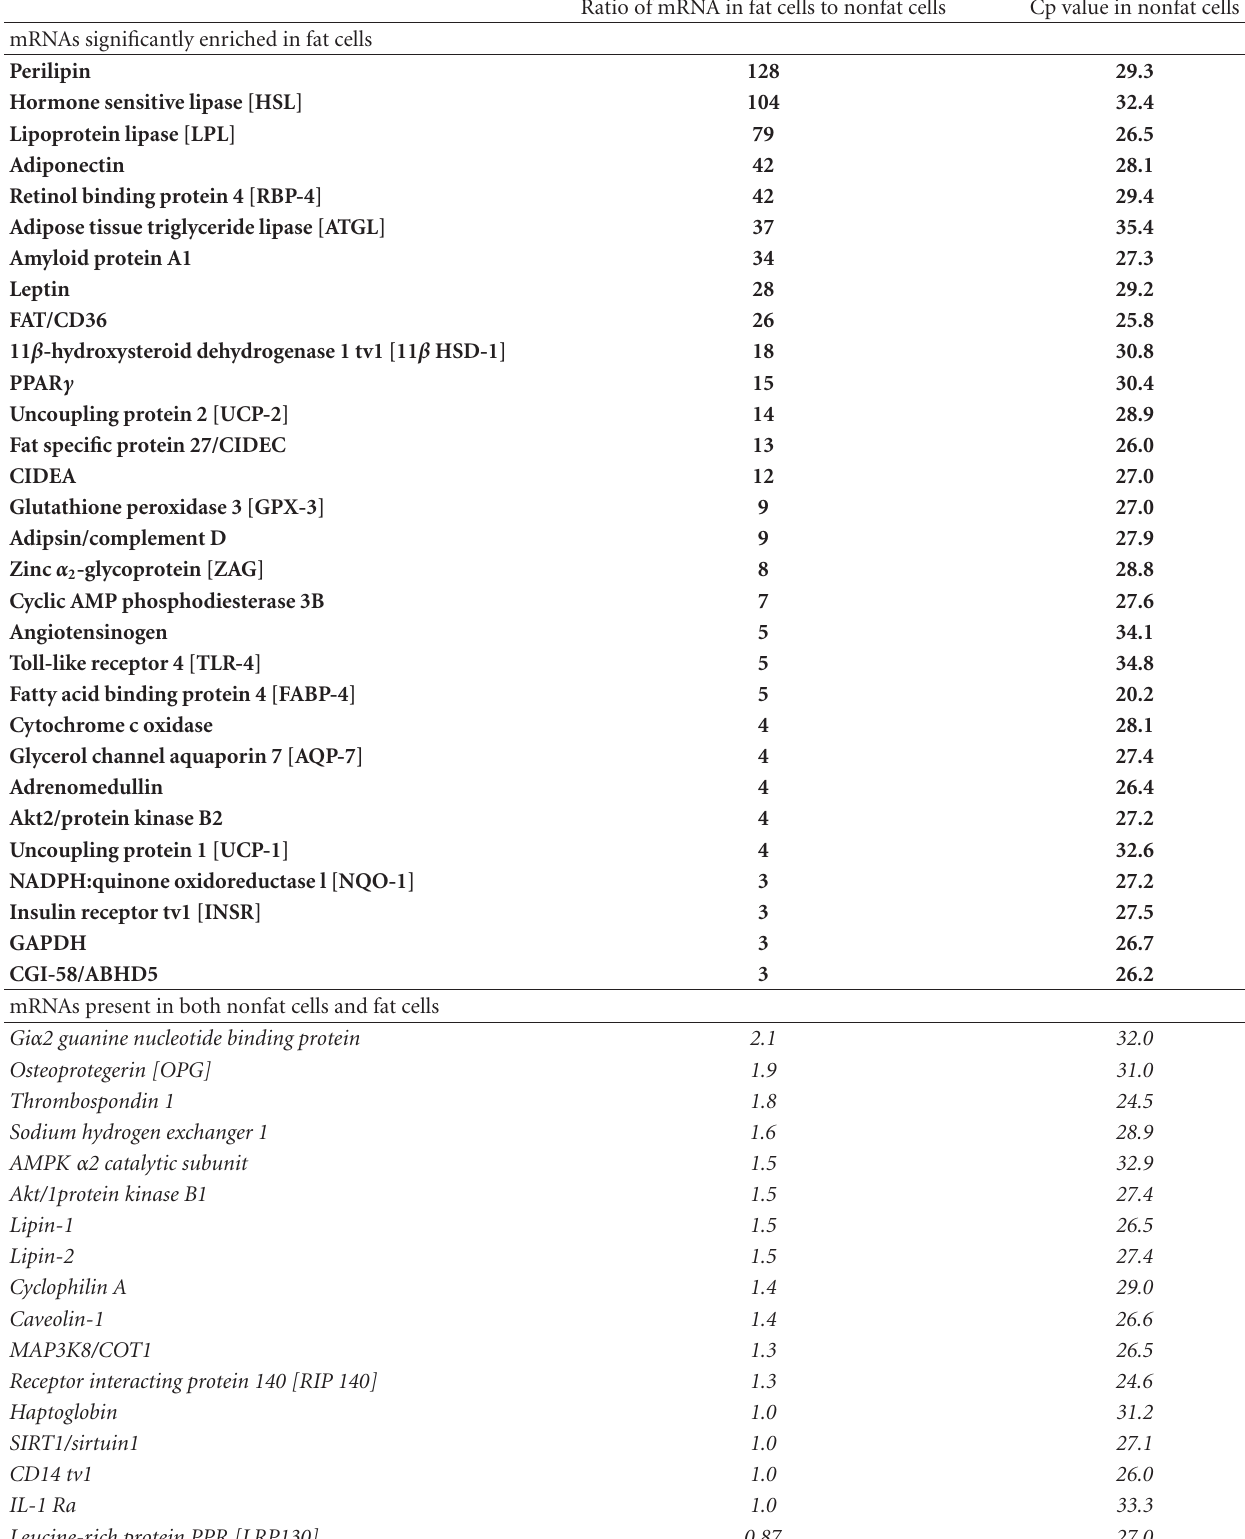
Table 2: Comparison of 100 mRNAs in fat cells as compared to the nonfat cells derived from human omental adipose tissue. Ratio of mRNA in fat cells to nonfat cells Cp value in nonfat